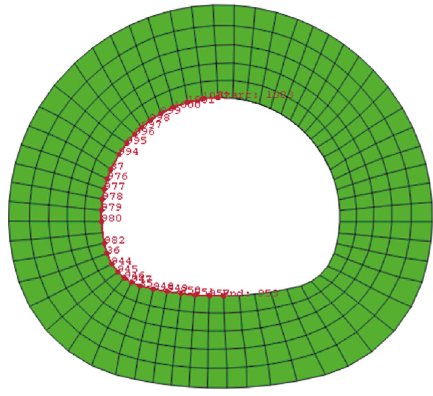
Figure 11: Flow rate output path